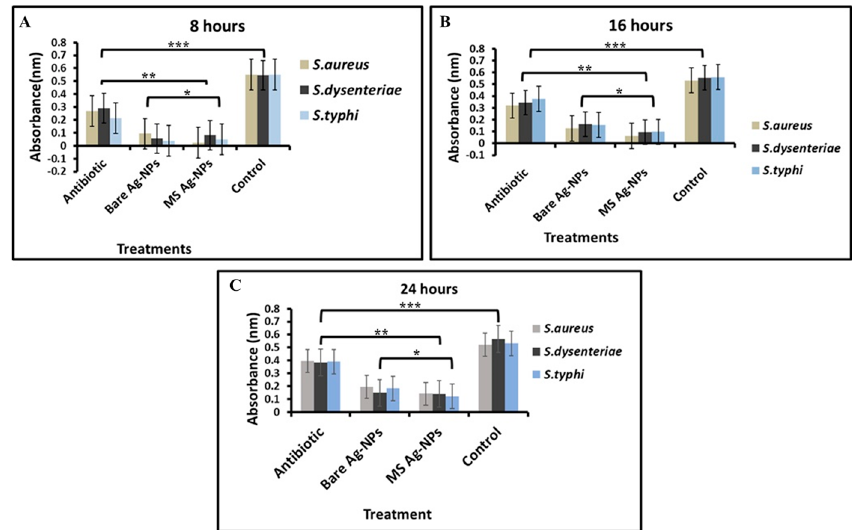
Figure 8. Optical density of the MS-AgNPs determined the growth of the bacteria in liquid broth at different time intervals (8, 16, 24 h). (A) Representative growth of the bacteria in liquid broth at 8 h, (B) representative growth of the bacteria in liquid broth at 16 h, and (C) representative growth of the bacteria in liquid broth at 24 h. Note: *** shows significant difference at p < 0.05, ** shows significant difference at p < 0.01, and * shows significant difference at p < 0.005.